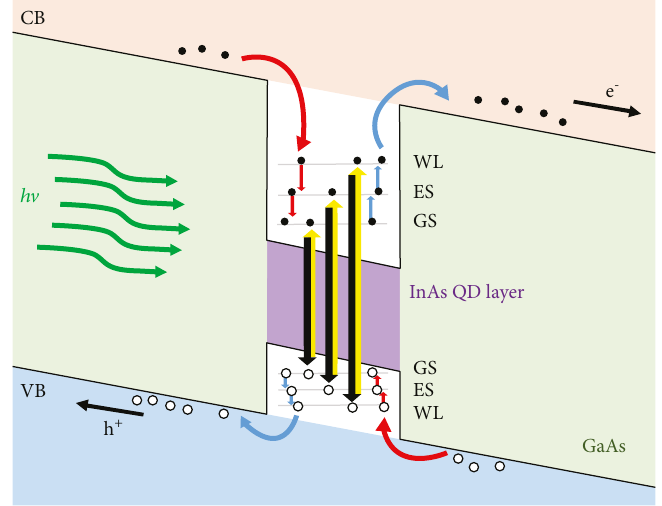
Figure 1: Energy band diagram of one InAs QD layer embedded in GaAs including all the carrier processes considered in the model: capture/ relaxation (red), escape (blue), photogeneration (yellow), and recombination (black). WL is treated as a 0D